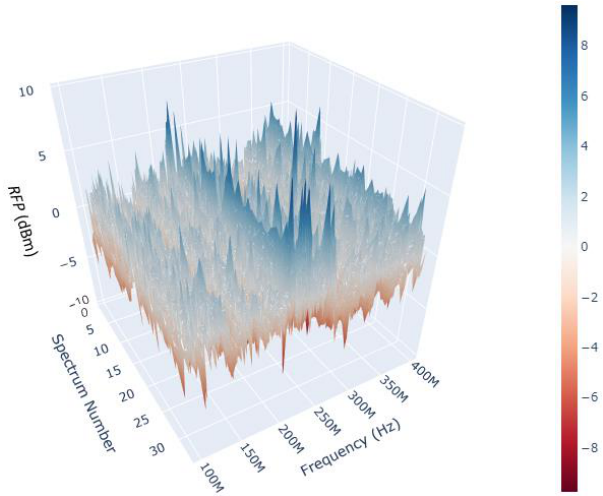
Figure 3. Received RF spectra for the spectra range 100-400 MHz across a 2 s long ablation process.